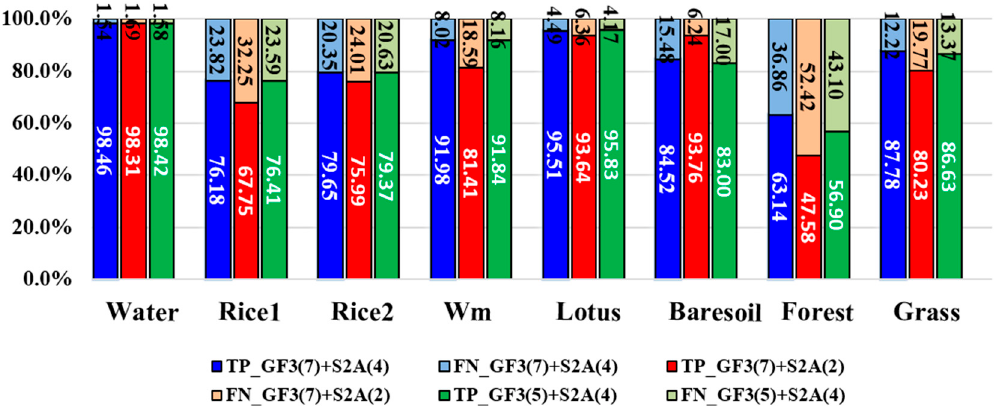
Figure 9. The classification results of ( a ) integration with of all features of dataset; ( b ) GF-3 (7 bands) + S2A (2 bands) and ( c ) denotes GF-3 (5 bands) + S2A (4 bands); ( d ) the testing sample.